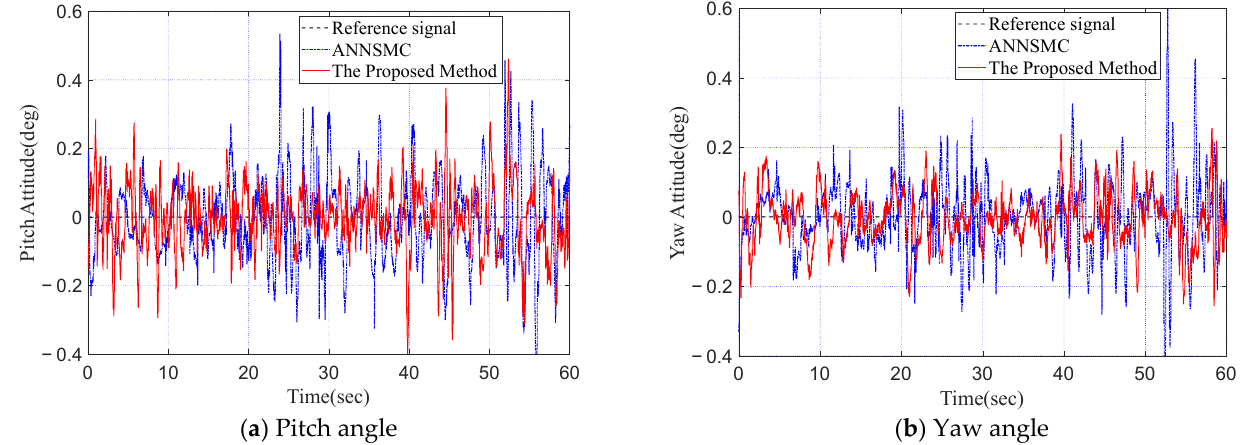
Figure 8. The control performances of the two controllers in Case 1.